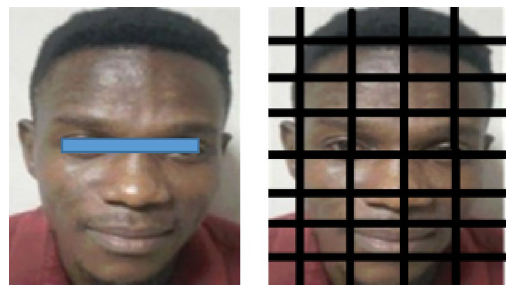
Figure 1. Face image divided into different